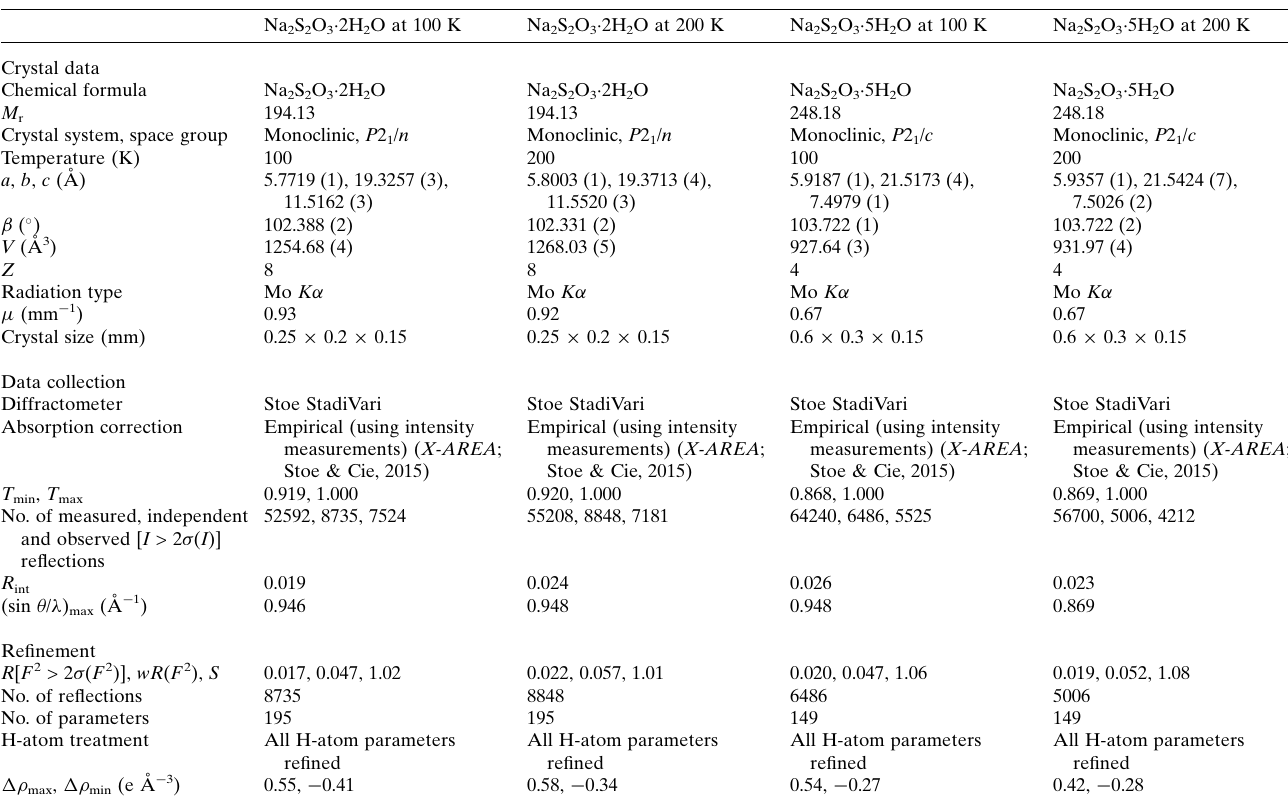
Table 3 Experimental